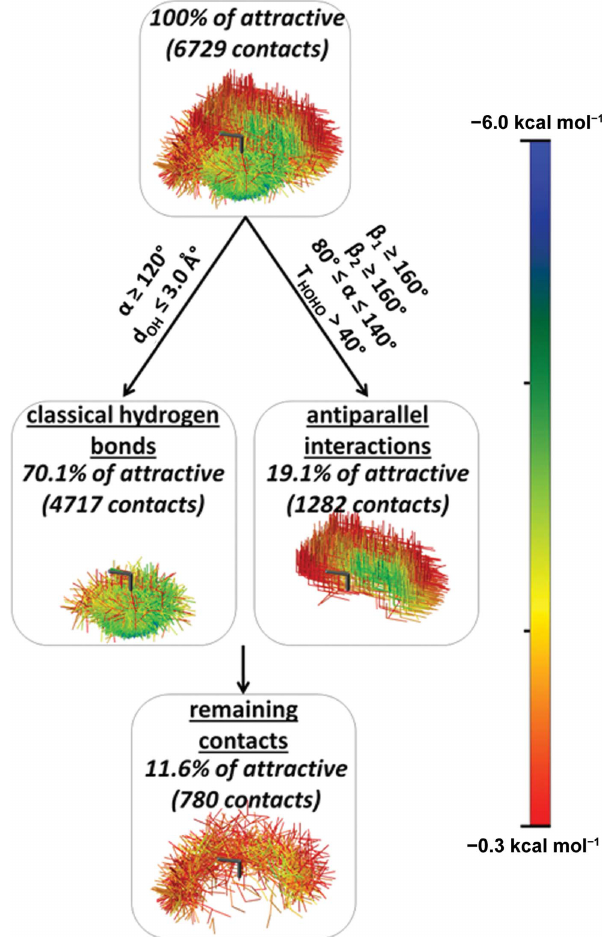
Figure 4 Sets of attractive water–water contacts found in the CSD. In the graphical representations of water–water contacts, one water molecule was positioned in the centre (shown in dark grey). The other water molecules from every water–water contact are shown in the colour representing the CCSD(T)/CBS interaction energies, as shown in the scale.